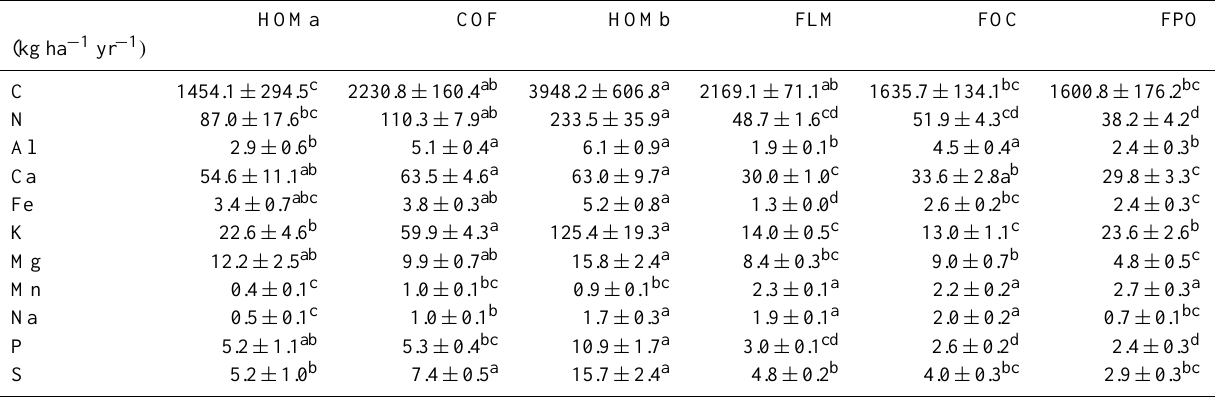
Figure 2. Monthly litterfall from May 2012 to July 2013 in Chagga homegardens (HOM), shaded coffee plantation (COF), lower montane forest (FLM), Ocotea forest (FOC) and Podocarpus forest (FPO). Total litterfall (squares) is divided into leaves (diamonds), branches (trian- gles) and rest (circles). Ten-year mean of monthly precipitation (2000 to 2010, TRMM, http://pmm.nasa.gov) is indicated as bars. Standard errors (SE) are displayed by error bars. Table 2. Annual nutrient deposition via leaf litterfall (Mean ± SE, kgha − 1 yr − 1 ) from six ecosystems at Mt. Kilimanjaro. Superscript letters indicate significant differences between sites (Kruskal–Wallis Test; p level ≤